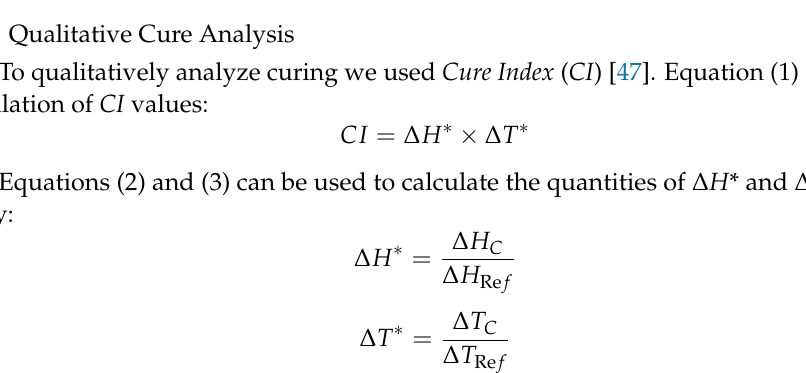
Figure 6. Nonisothermal thermograms of DSC conducted on the blank epoxy and epoxy systems with 0.1 wt % Mica or Mica-IM nanoparticles, varying β as 5 ◦ C min − 1 ( a ), 10 ◦ C min − 1 ( b ), and 15 ◦ C min − 1 ( c